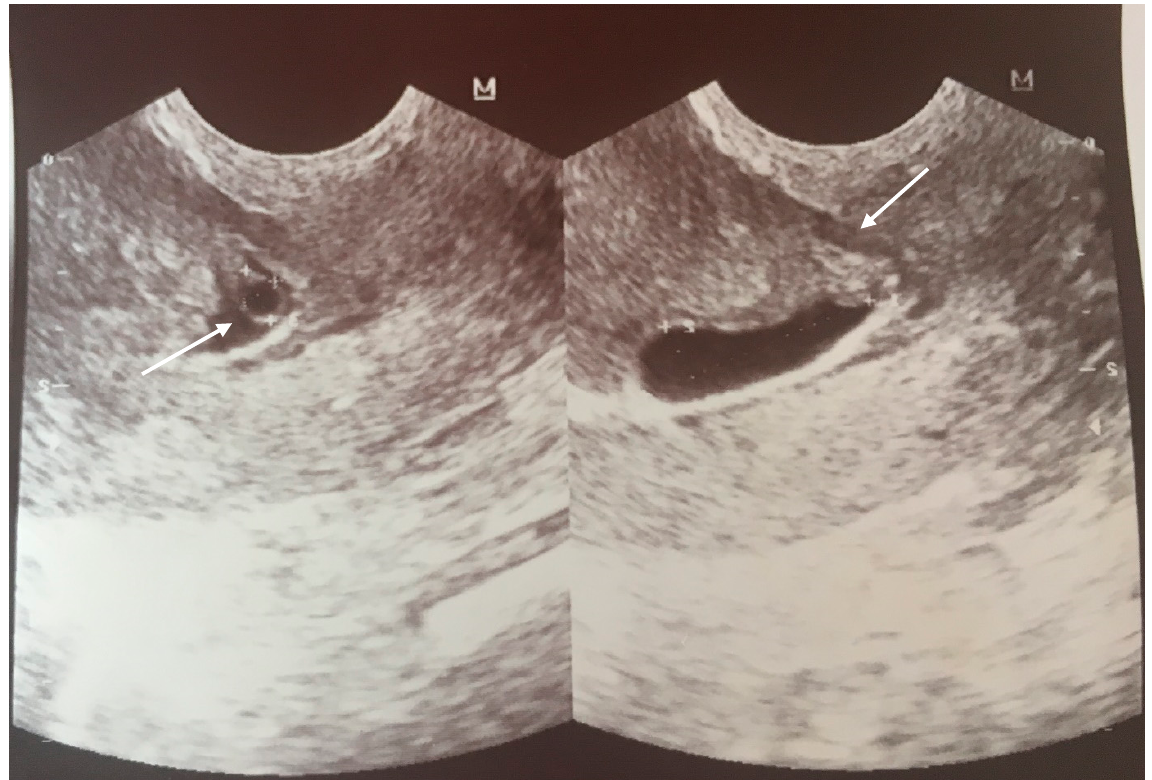
Figure 1. Transvaginal scan at 6 wks with a visible gestational sac in the area of the scar after CS (the arrows are pointing to GS and scar).